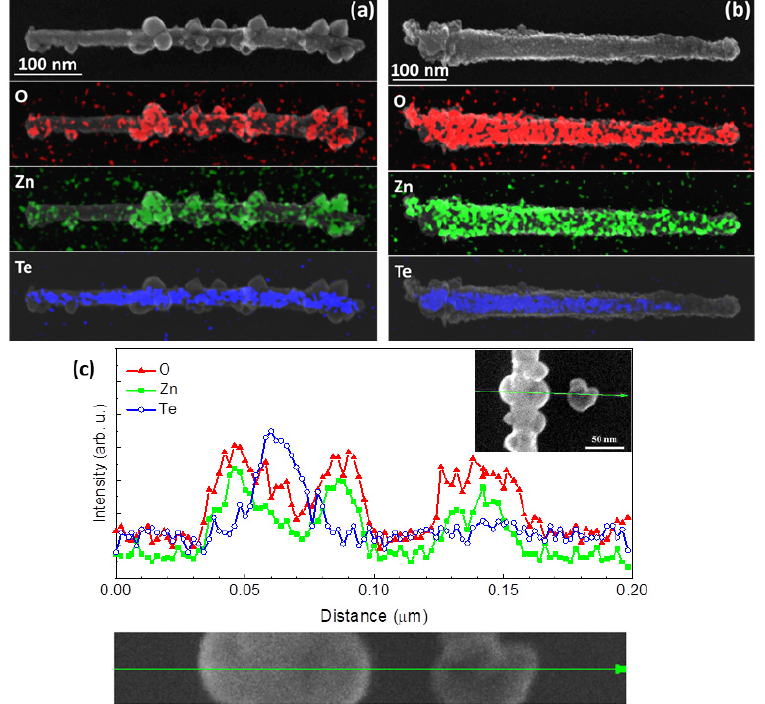
Figure 3. Scanning electron microscopy micrographs of oxidized ( a ) ZnTe and ( b ) ZnTe/Zn NW and related to them energy dispersive X-ray (EDX) spectroscopy distribution maps of O, Zn, and Te. ( c ) Transverse EDX line scan running across the oxidized ZnTe NW and one of its loose crystallites. Data corresponding to O, Zn, and Te yields are plotted as red triangles, green squares, and blue circles, respectively. The experimental configuration is depicted in two insets. Below and at the top right corner of the main graph.